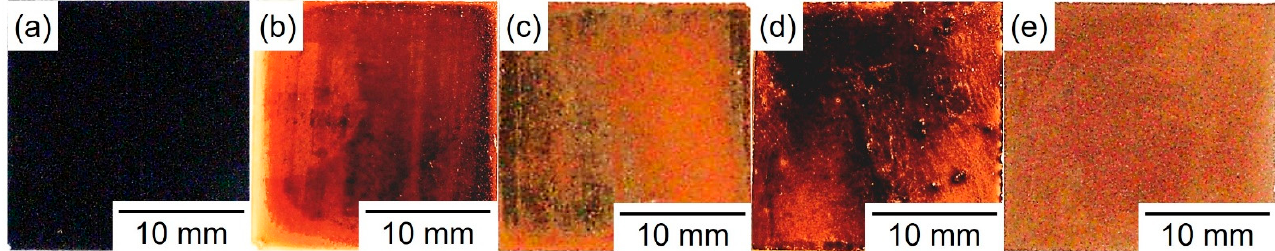
Figure 2. Effect of annealing temperature on the surface appearance of electrodeposited ZnTe thin films onto ITO glass substrates. As-deposited samples ( a ) were annealed at 653 K ( b ), 663 K ( c ), 673 K ( d ), and 683 K ( e ) for 5 h.